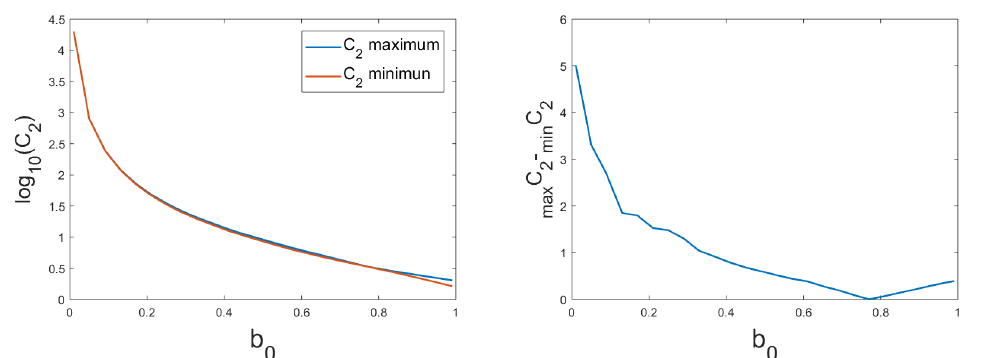
Figure 1. Numerical estimate of the stability constant C 2 in (24) for h = 10 − 4 . To illustrate the behavior on b , we plotted the maximum and minimum value when q ∈ F h , b with respect to b in logarithmic scale ( left ), and its range in normal scale ( right